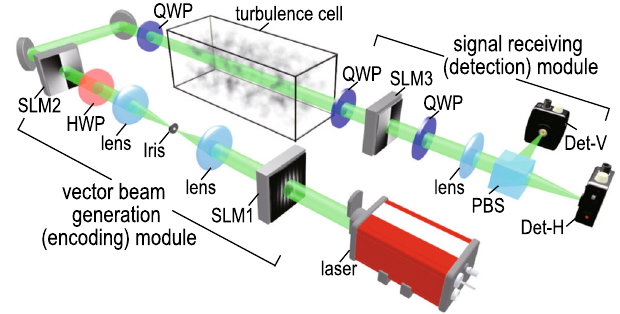
Fig. 1 Spatial pro fi les of vector beams. The spatial polarization pro fi les of ten vector beams comprised of Laguerre – Gaussian (LG) beams in the circular polarization basis with opposite OAM charges along with 0 or π relative phase difference. The color indicates the polarization orientation while the color saturation indicates the beam intensity. The black lines indicate the local polarization state across the